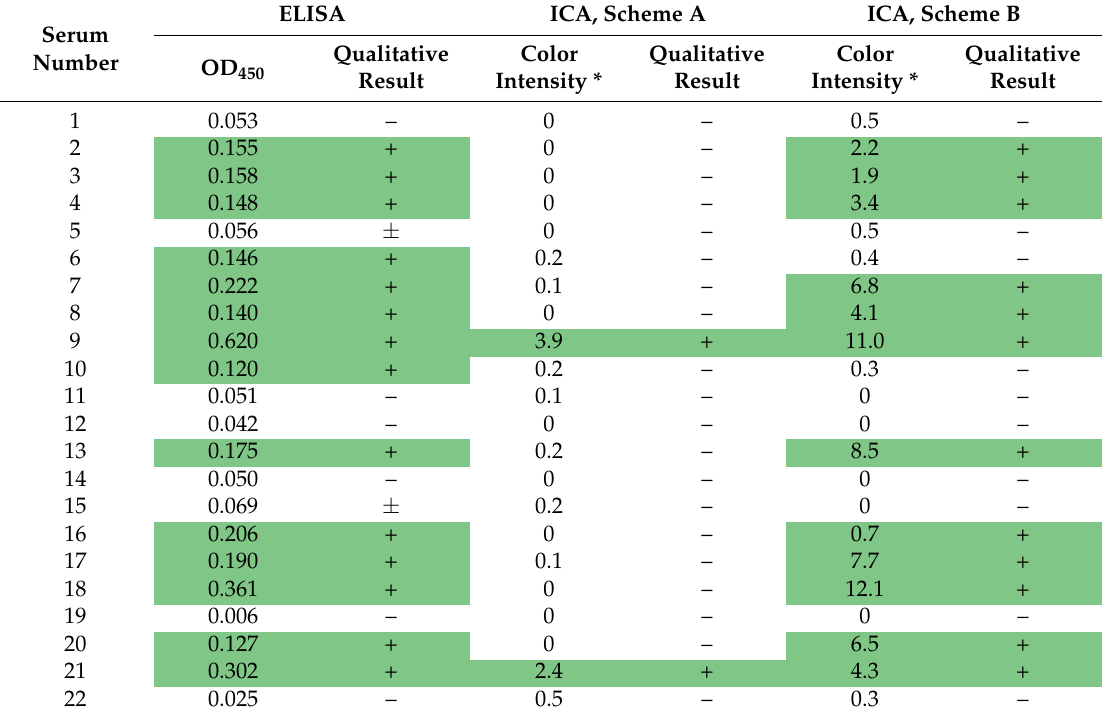
Figure 5. Tested sera of tuberculosis patients by schemes A and B of immunochromatographic serodiagnostics. Table 1. Results of testing sera from patients with respiratory tuberculosis using ELISA and the 2 ICA schemes (average values for triplicate measurements).